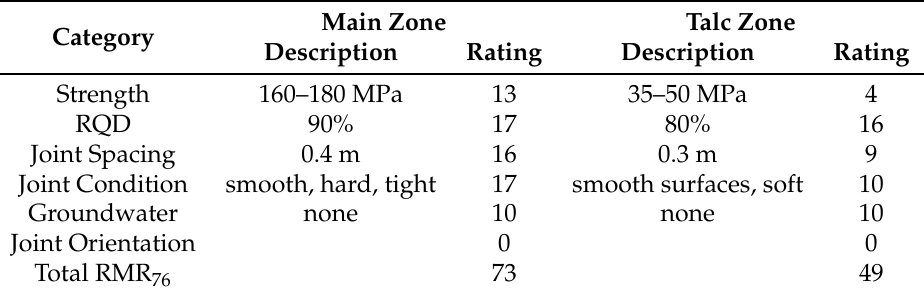
Table 1. Rock Mass Rating (RMR 76 ) at Detour Lake Mine.